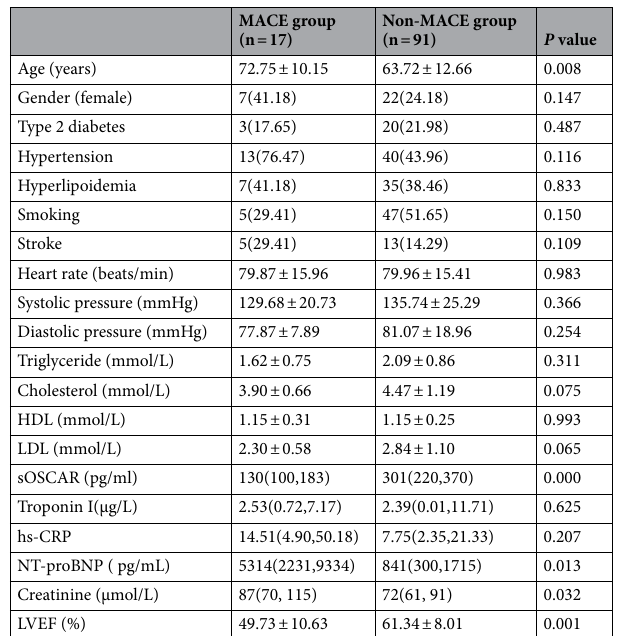
Table 1. Comparisons of baseline data between the MACE group and non-MACE group [n, %, x ± s, P50 (P25-P75)]. MACE major adverse cardiovascular events; LVEF left ventricular ejection fraction;